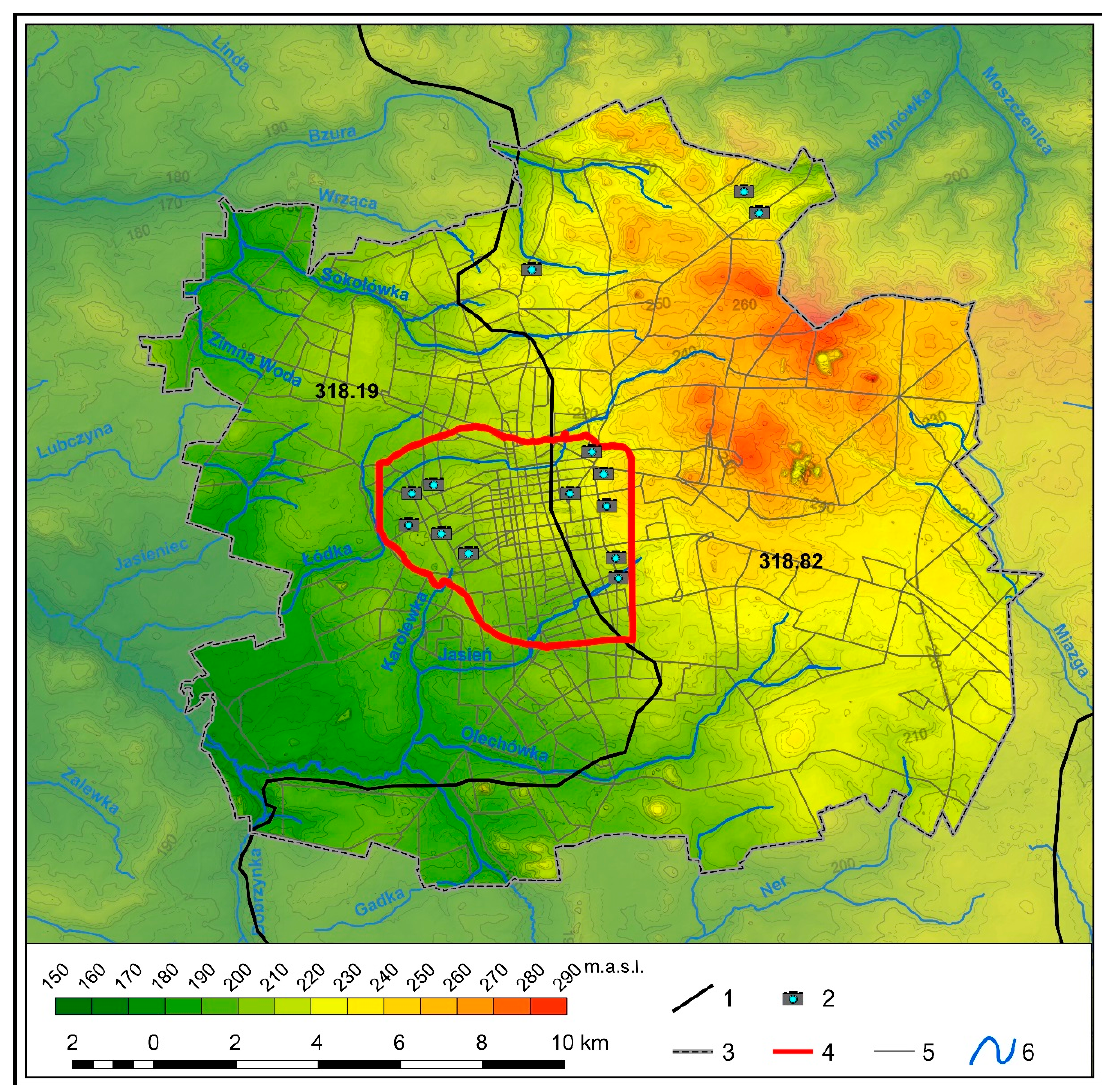
Figure 2. The relief of Ł ód ź and its immediate surroundings. 1—boundaries of physico-geographical mesoregions; 2—location of photographs presented in the article; 3—administrative boundaries of Ł ód ź ; 4—scope of Jasi ń ski’s map (1917); 5—main roads; 6—watercourses. Source: Own study based on GUGiK and MPHP data .